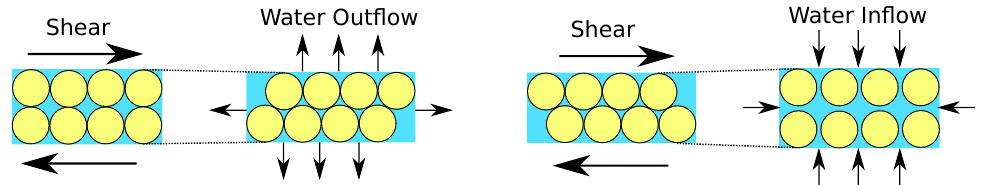
Figure 2. Behaviour of loosely-packed sand ( left ) versus densely-packed sand ( right ) under shear